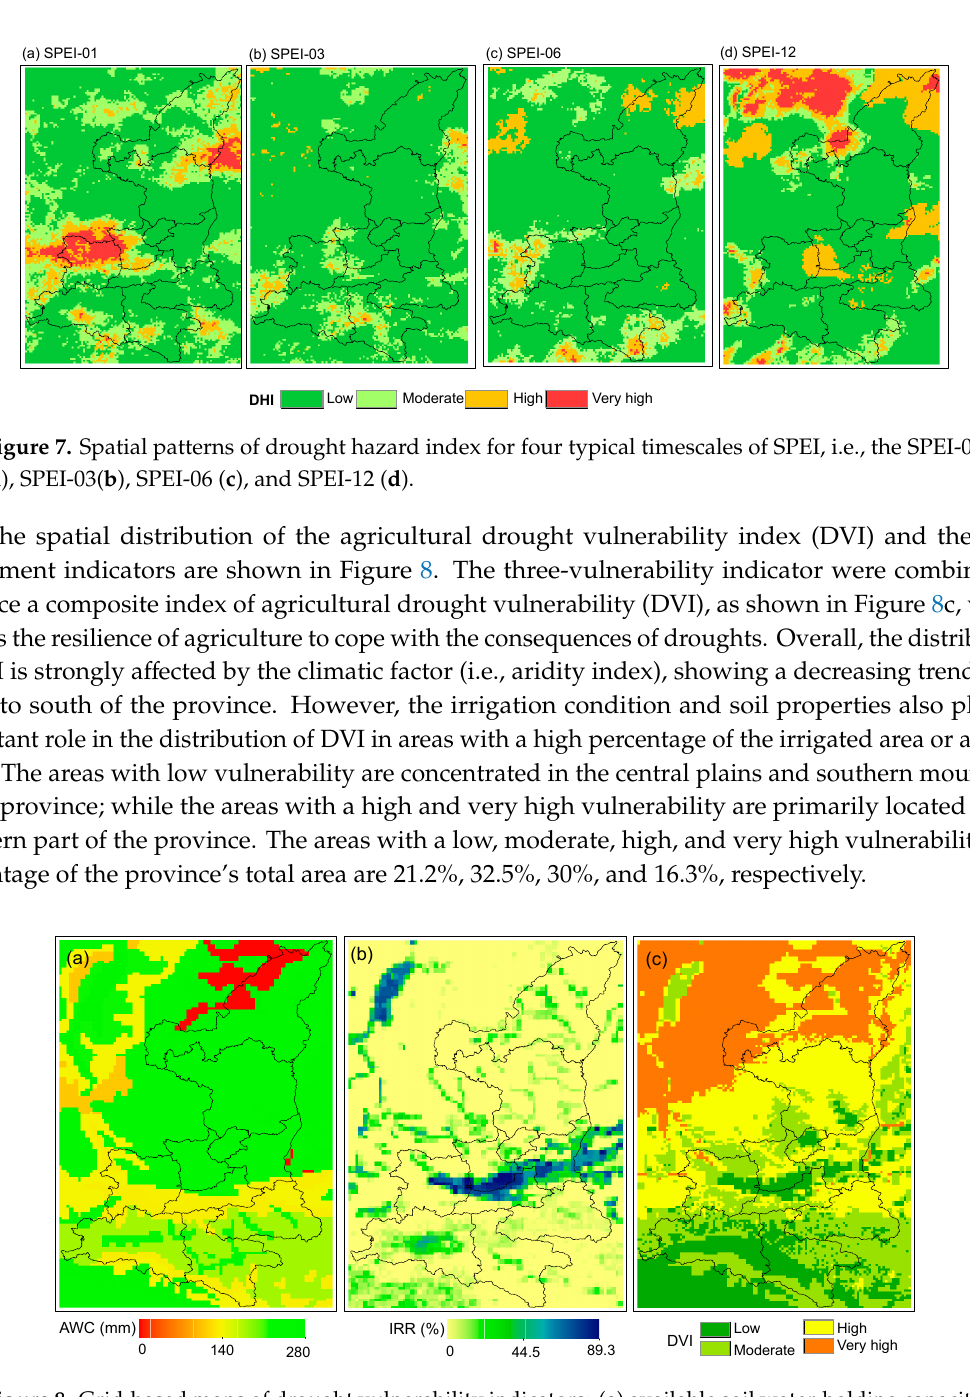
Figure 8. Grid-based maps of drought vulnerability indicators: ( a ) available soil water-holding capacity (AWC, mm) and ( b ) the percentage of area equipped for irrigation (IRR, %). ( c ) The spatial pattern of agricultural drought vulnerability index (DVI). The assessment indicator AI (aridity index) has been shown in Figure 1b and thus is not presented in this